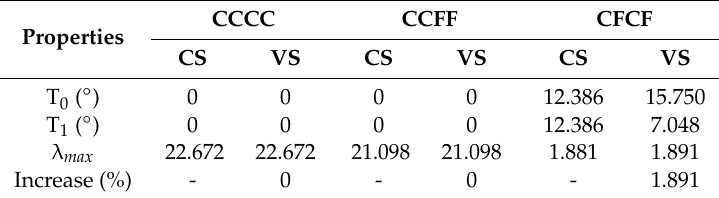
Table 14. Optimal angles of a single layer VS plate for maximum uniaxial load multipliers, with clamped boundary conditions.